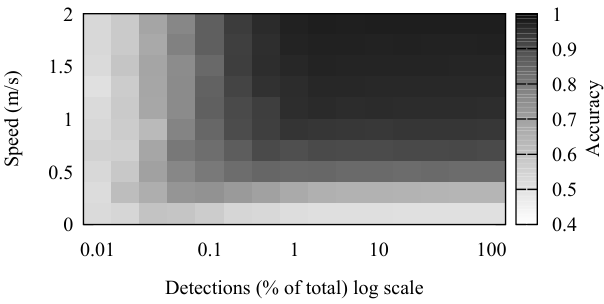
Figure 4. Effects of speed and detection frequency on the accuracy of stay point detection.